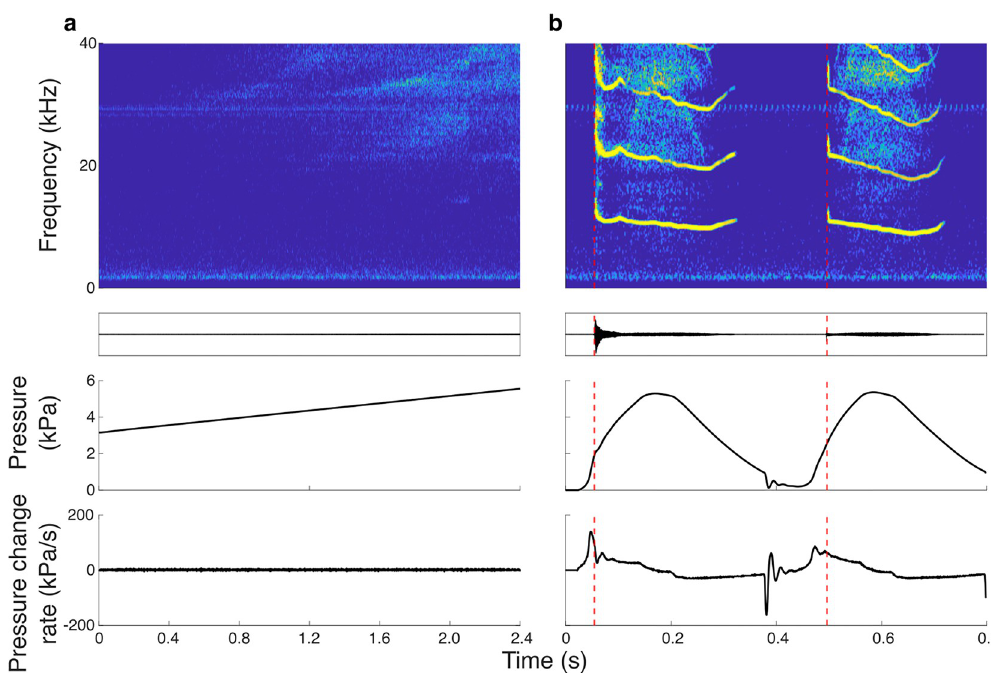
Fig 3. Oscillation onset of vocal membranes requires fast pressure modulation compared to ventricular folds. (a) Sound spectrograms during slow 1 kPa/s bronchial pressure show that vocal membranes did not oscillate during slow ramps (in 3 out of 4 individuals). (b) Driven by fast pressure modulation, vocal membranes reliably vibrated. Red vertical dashed lines show the onset for PTP detection. The data underlying a and b can be found in S4 and S5 Data